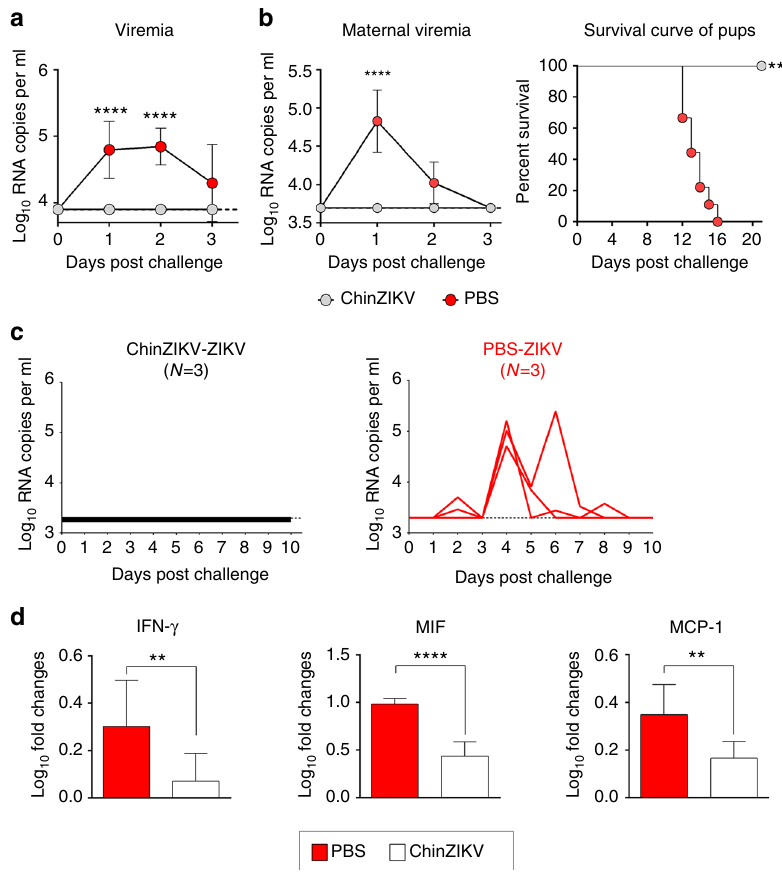
Fig. 4 A single dose of ChinZIKV confers complete protection against ZIKV challenge in mice and monkeys. a Viral load in the sera of immunized mice after ZIKV challenge. The ChinZIKV immunized mice were challenged i.p. with 10 3 PFU of ZIKV. Viral RNA loads were determined by RT-qPCR. Dotted lines indicate the detection limit. The data are representative of at least three independent experiments, and error bars indicate the SD. Signi fi cance was calculated using a two-way ANOVA with multiple comparison tests (**** P -value < 0.0001). b Four-week-old female BALB/c mice were immunized with 10 4 PFU of ChinZIKV ( n = 3) or PBS ( n = 2) as a control. On day 60 post immunization, the immunized mice were mated to 10-week-old male BALB/c mice. At embryonic day 13.5 (E13.5), the pregnant mice were infected with 10 5 PFU of ZIKV by the i.p. route. Viral RNA loads at days 1 – 3 post-infection were determined by RT-qPCR. Dotted lines indicate the detection limit. The data are representative of at least three independent experiments, and error bars indicate the SD. Signi fi cance was calculated using a two-way ANOVA with multiple comparison tests (**** P -value < 0.0001). One-day-old suckling mice born to the ChinZIKV-immunized ( n = 15) or PBS-immunized ( n = 9) dams were challenged i.c. with 100 PFU of ZIKV. The mice were then monitored for clinical symptoms and mortality for 21 days. Asterisks indicate values that are statistically signi fi cant (*** P -value < 0.001). c The PBS- or ChinZIKV- immunized monkeys were challenged s.c. with 10 3 PFU of ZIKV. Serum and body fl uids were collected at the indicated times. Viral RNA amounts were determined by RT-qPCR. Dotted lines indicate the detection limit. d Cytokine amounts in the sera of the PBS- or ChinZIKV-immunized monkeys ( n = 3, each group) at day 7 post challenge determined by a Monkey Cytokine Magnetic 29-Plex Panel kit. Experiments were performed in duplicate (error bars represent SD). Signi fi cance was calculated using the Student ’ s t test (** P -value < 0.01; **** P -value <